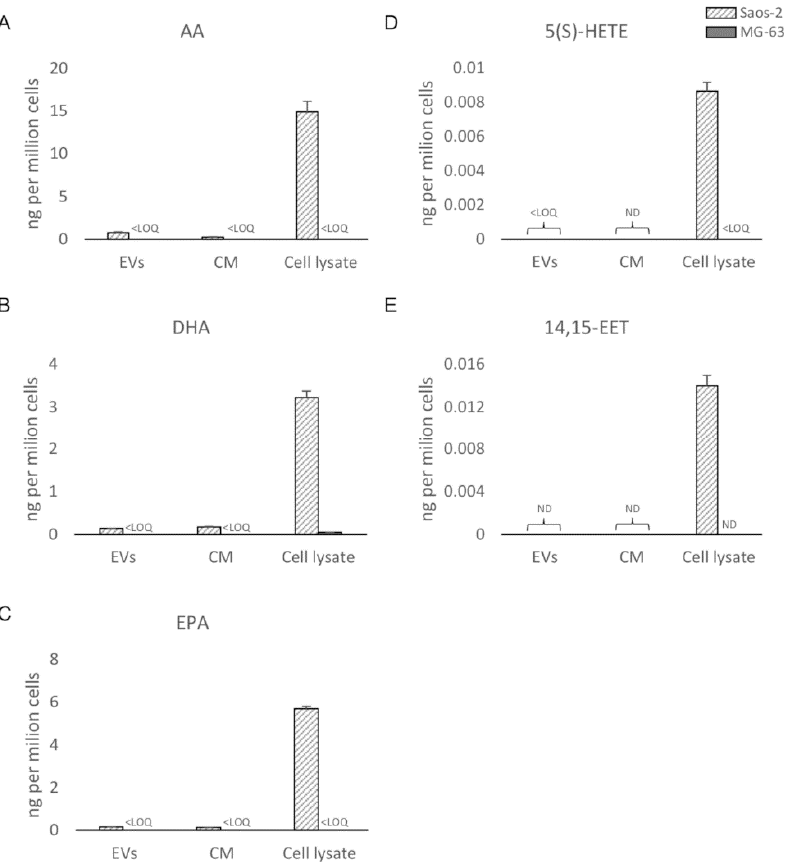
Figure 5. UHPLC-MS / MS quantitation (ND = not detectable; LOQ = limit of quantitation) in EVs, CM, and cell lysate from Saos-2 and MG-63 cell lines of ( A ) arachidonoyl acid (AA); ( B ) Docosahexaenoic acid (DHA); ( C ) eicosapentaenoyl acid (EPA); ( D ) 5-hydroxyeicosatetraenoic acid (5( S )-HETE; ( E ) (±)14(15)-epoxyeicosatrienoic acid (14,15-EET).